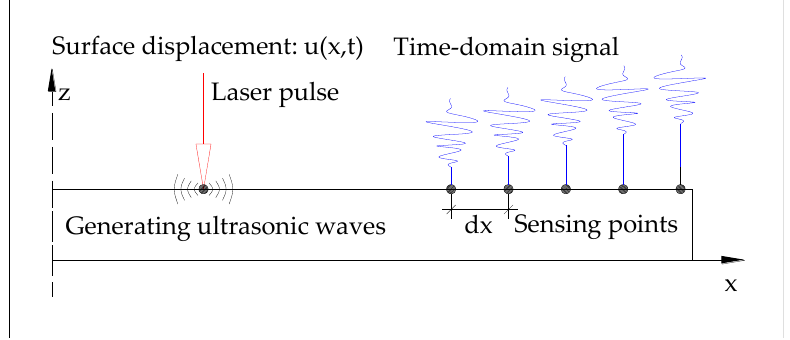
Figure 2. Ultrasonic wave mode generation in a plate. A source of impulsive pressure is applied to the surface and the resulting time records are tracked at different locations on the surface [53].